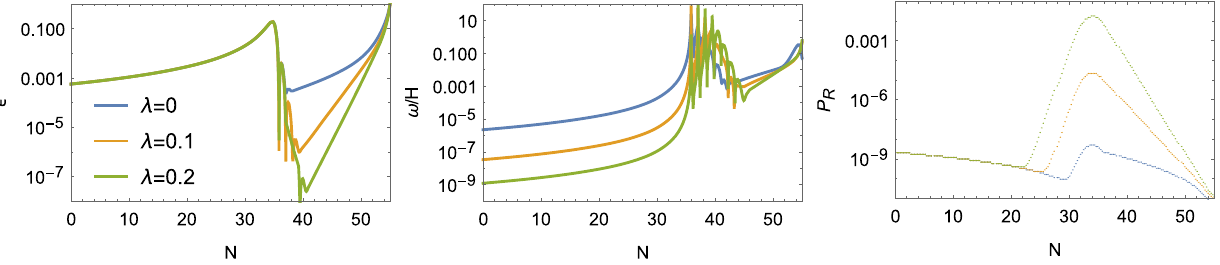
Fig. 10 The slow-roll parameter (cid:14) , the turn rate ω/ H and the power spectrum P R with the parameters in Table 4. The color coding is shown on the left